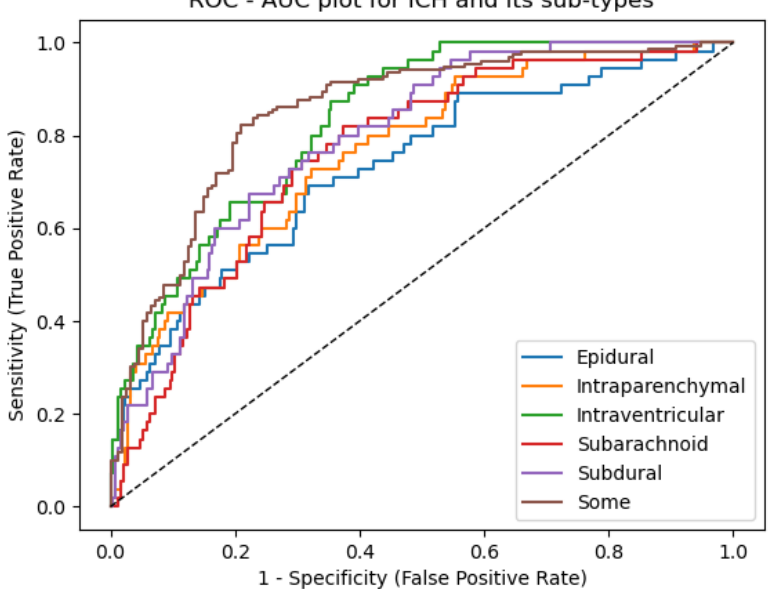
Figure 8. ROC-AUC plot for ICH and its sub-types. Table 6. ROC-AUC score for different labels.